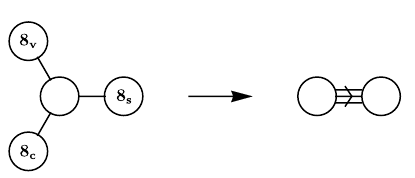
Figure 8 . The outer-automorphism acting on D 4 diagram of so 8 leads to G 2 diagram of g 2 .